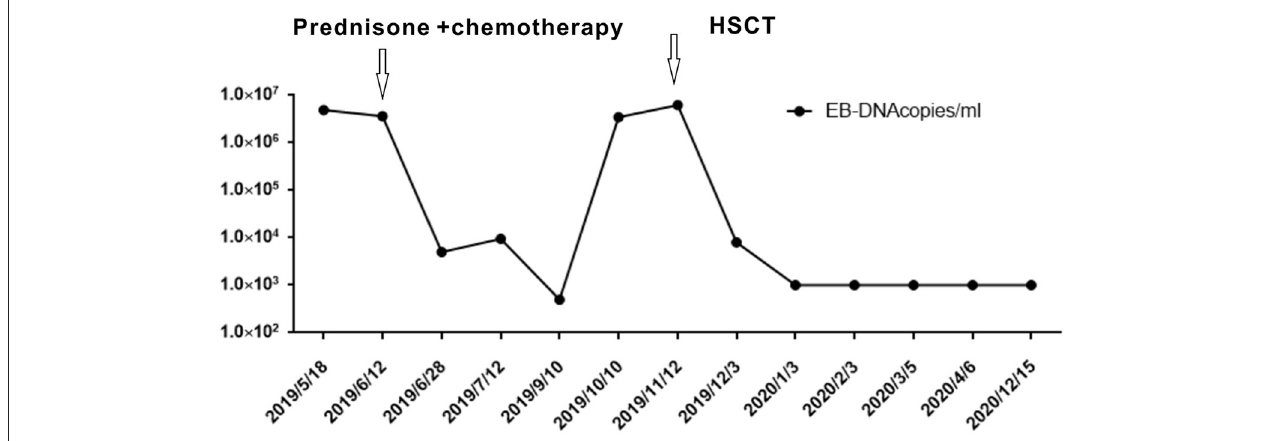
FIGURE 3 | Epstein–Barr virus (EBV) viral load from 2019 to 2020.